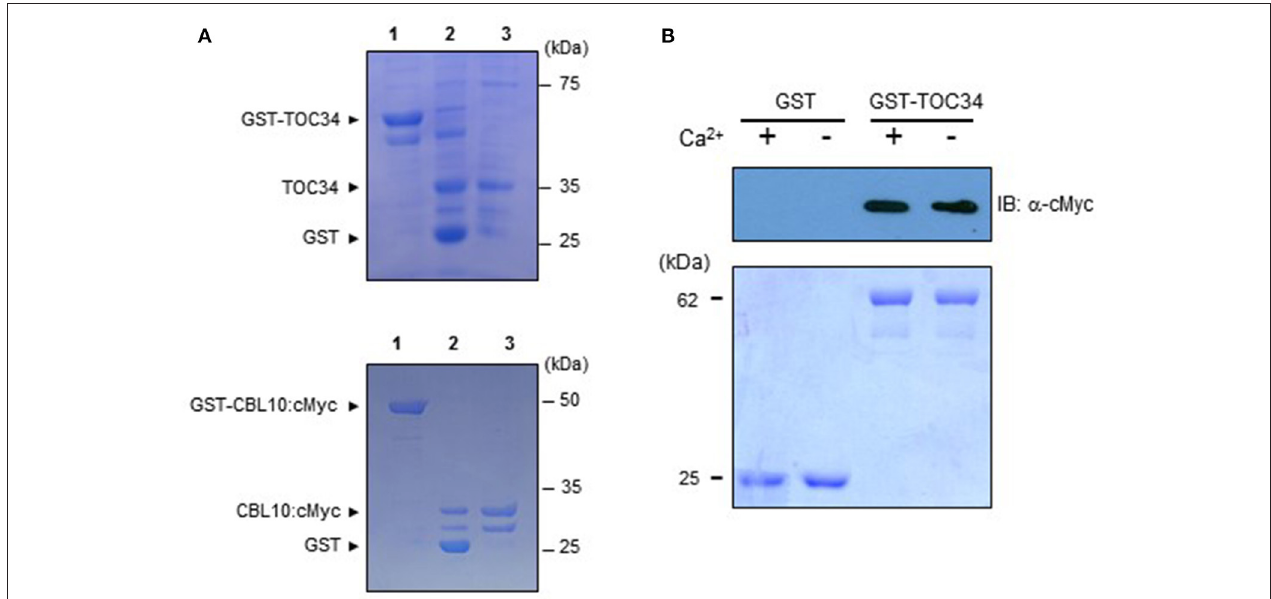
FIGURE 4 | Interaction between TOC34 and CBL10 in a calcium-independent manner. (A) Purification of the recombinant TOC34 (top) and CBL10:cMyc (bottom) proteins expressed in Escherichia coli . Lanes 1 to 3 contain the GST-TOC34 or CBL10:cMyc, the thrombin-digested forms of GST and TOC34 or CBL10:cMyc, and purified TOC34 or CBL10:cMyc, respectively. SDS-PAGE gels were stained with Coomassie Brilliant Blue. (B) Pull-down assy. The GST-TOC34 fusion protein was used as a bait to pull down the prey CBL10:cMyc in the presence ( + , 1mM CaCl 2 ) or absence ( − , 2mM EGTA) of calcium. For a negative control, GST alone was used as a bait. The top panel shows a western blot probed with rabbit anti-cMyc antibody and the bottom panel shows a Coomassie Brillant Blue stained SDS-PAGE gel indicating the amount of bait proteins used in each pull-down